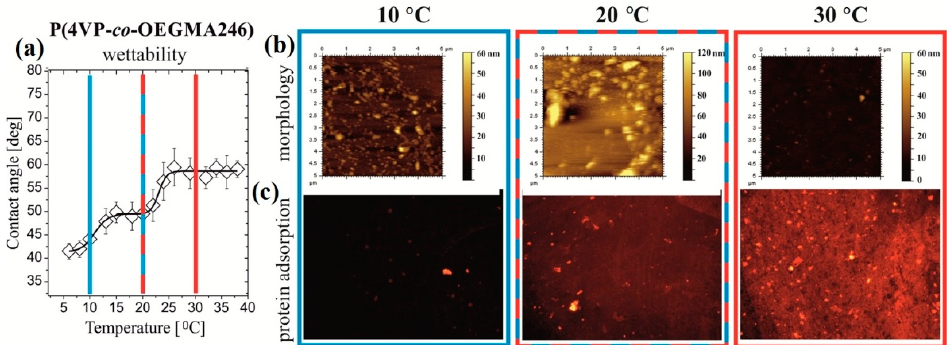
Figure 12. Temperature-controlled three-stage switching of wetting ( a ), morphology ( b ), and BSA absorption ( c ), determined for copolymer poly(4-vinylpyridine- co -OEGMA246) TRPBCs. Representative micrographs recorded with AFM ( b ) and fluorescence microscopy (for BSA molecules) labeled with Alexa Fluor ( c ) (with permission from [154]). TRPBCs with terpolymer brushes of poly( N IPAM- co - N , N - dimethylaminopropylacrylamide- co - N - tert -butylacrylamide) were fabricated and applied for the separation of HSA albumin and γ -globulin [155]. A negatively charged HSA was adsorbed on cationic terpolymer brush-modified silica beads at higher temperatures with a low concentration of phosphate buffer at pH = 7.0. In the work [156], TRPBCs with